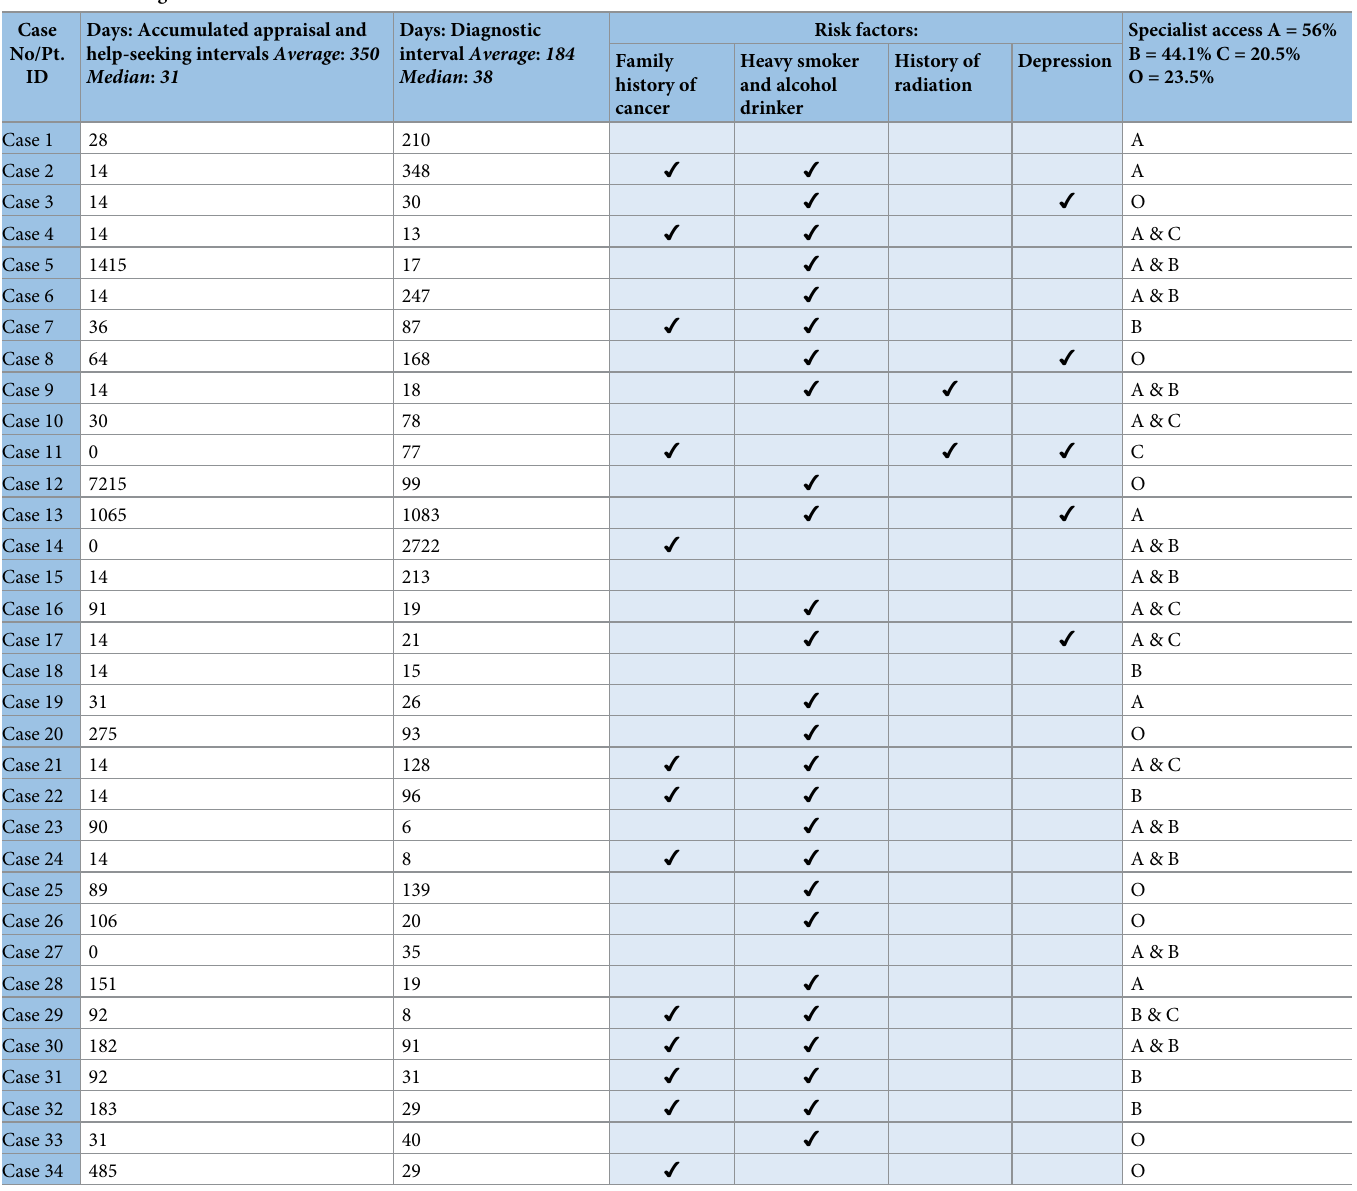
Table 3. Main categories